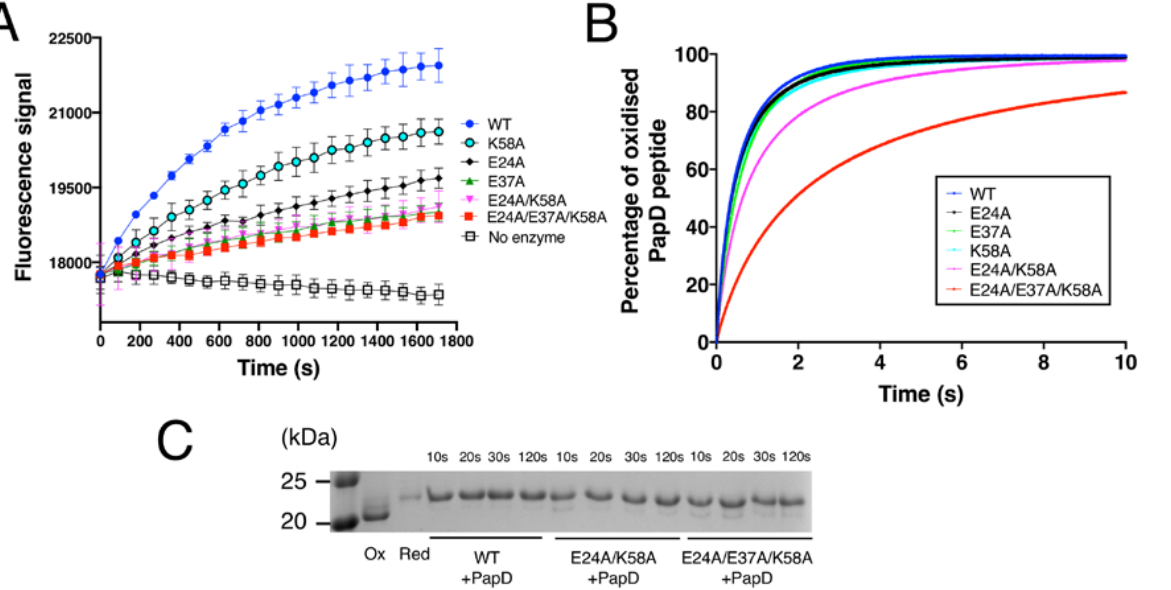
Figure 5. Functional characterisation of EcDsbA mutants. ( A ) Thiol-disulphide oxidase activity of EcDsbA mutants was determined by monitoring the oxidation of a fluorescently labelled peptide derived from substrate PilQ. Data points shown in the figure are mean ± standard error of the mean (SEM), n = 3. ( B ) Kinetics of the disulphide exchange reaction between EcDsbA mutants and a 10-mer peptide derived from substrate PapD at pH 7.0 and 25 ◦ C. All reactions were performed in a stopped-flow fluorescence instrument under the second-order condition with initial concentrations of 1 µ M for EcDsbA and 1 µ M for PapD-derived peptide. Kinetics of reactions were determined by monitoring the increase in fluorescence upon reduction of EcDsbA. Experiments were repeated on three independent occasions and a representative curve is presented for each DsbA mutant. ( C ) Electron transfer assay for EcDsbA mutants and the PapD-derived peptide. Oxidised EcDsbA mutants and reduced PapD-derived peptide were mixed in a 1:1 molar ratio. Samples were taken from the reaction mixture after 10 s, 20 s, 30 s and 120 s and treated with 10% TCA. Free cysteines were labelled with AMS and samples were analysed by SDS-PAGE. Only part of the gel is shown for clarity, the full SDS-PAGE gel is shown in Figure S4. Table 2. Kinetic parameters of DsbA mutants. Initial rate and rate constants are expressed as mean ± standard error of the mean (SEM) with at least three independent replicates.